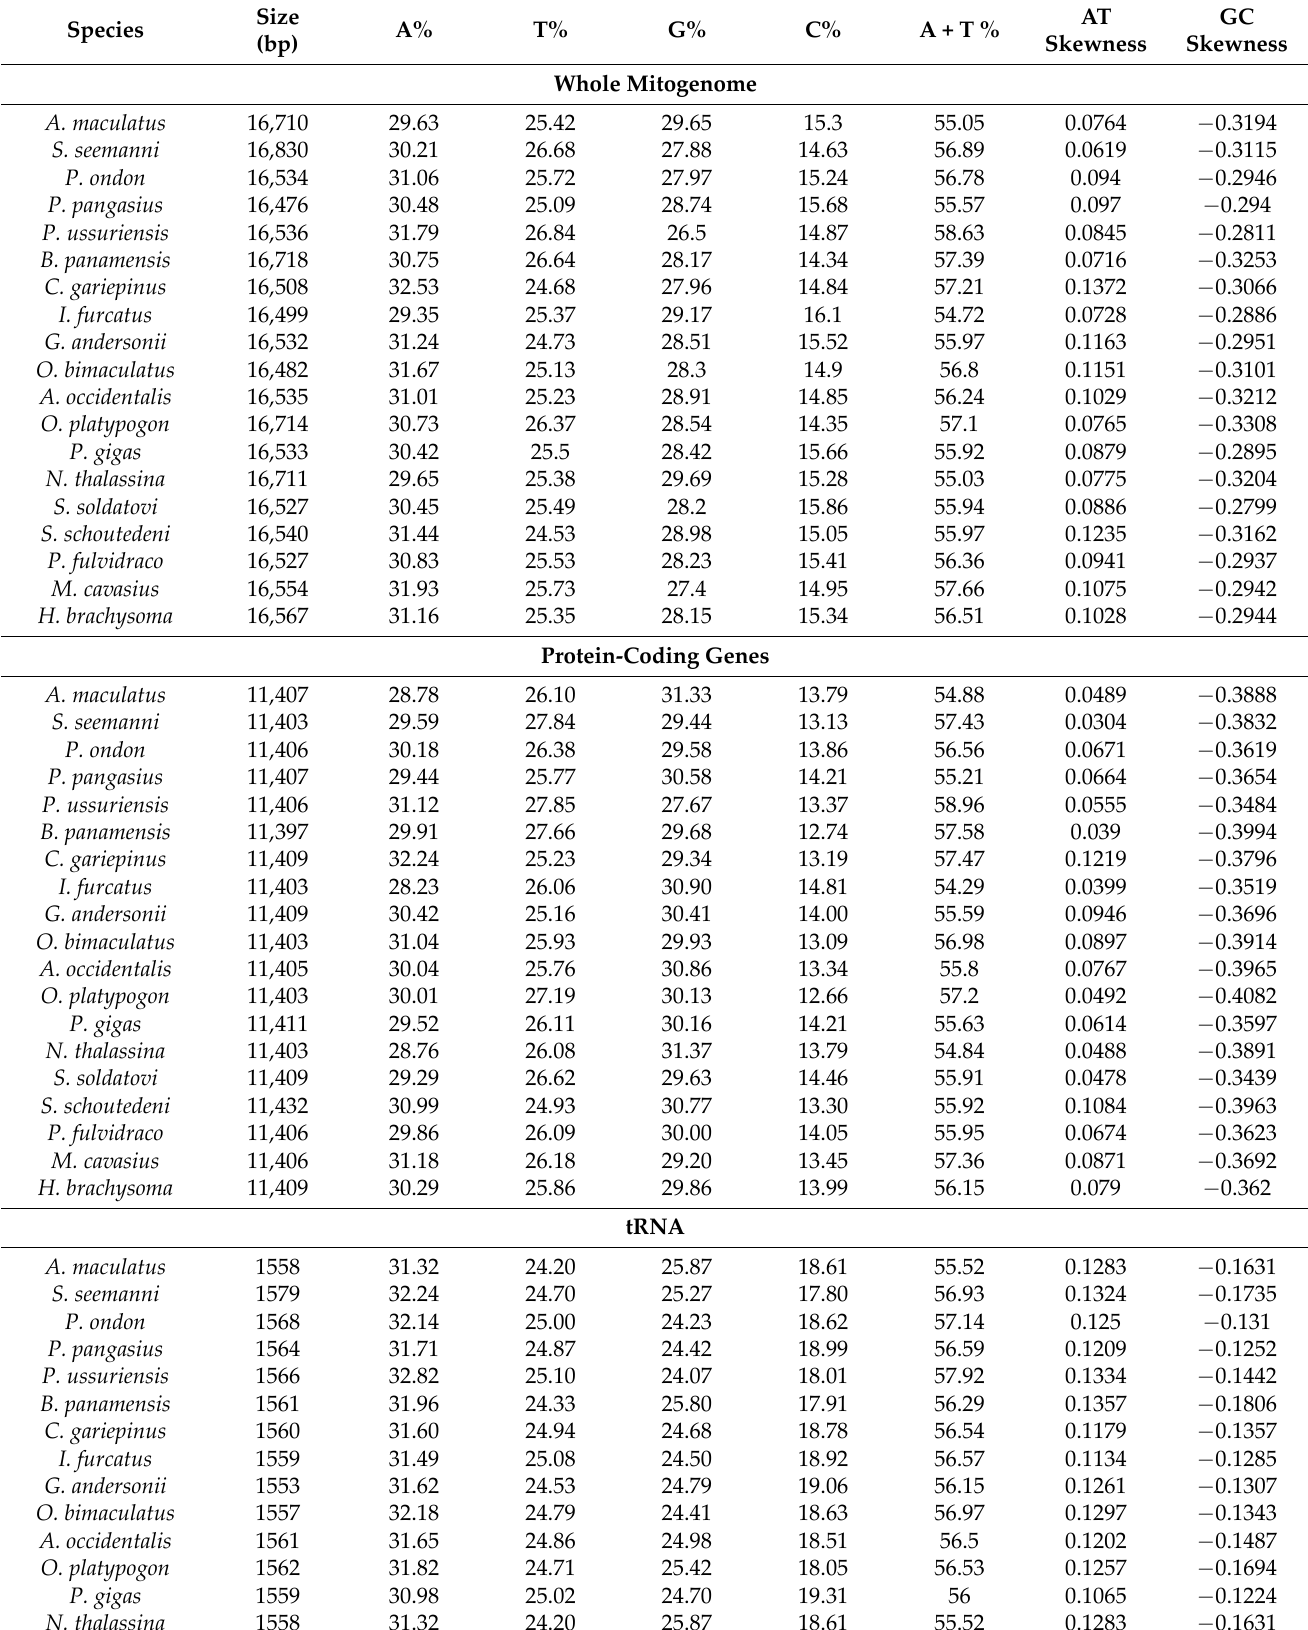
Table 2. Nucleotide composition of the mitochondrial genome in different